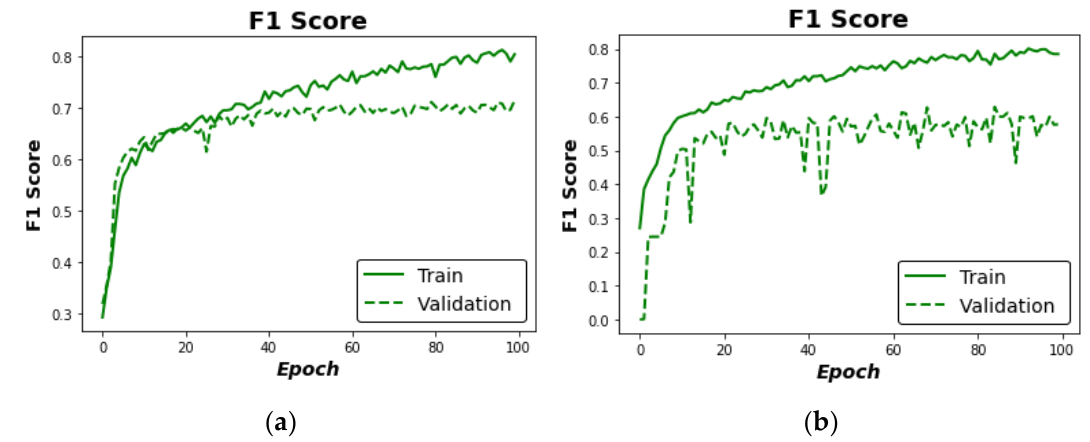
Figure 18. ( a ) U-Net with L1 F1 curve; ( b ) DeepLabV3+ with L1 F1 curve.